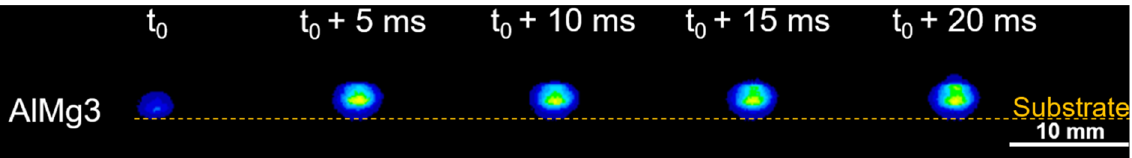
Figure 3. Optical images of laser welded AlMg3 alloy cross-sections: ( a ) weld seam conducted with laser beam tilt at 40° and 12 passes, ( b ) weld seam obtained by single irradiation with a beam perpendicular to the sample surface and ( c ) weld seam with the laser beam tilt at 40° and 2 passes.